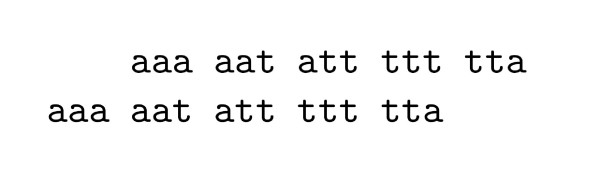
The alignment for π(sA).